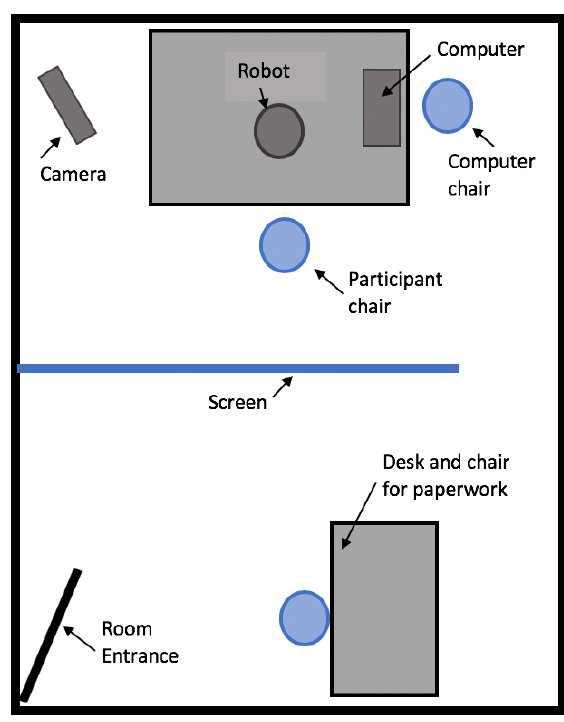
Figure 4: Experimental